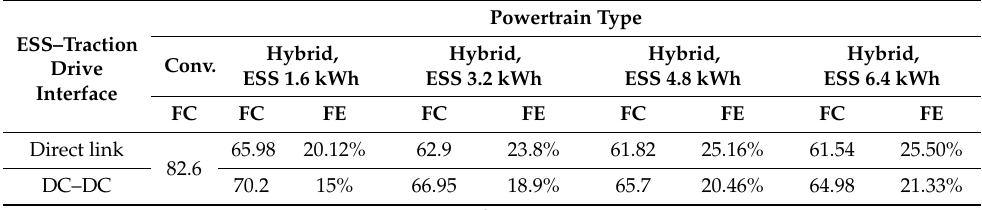
Table 8. Influence of the ESS energy content and the DC interface on the HEV fuel